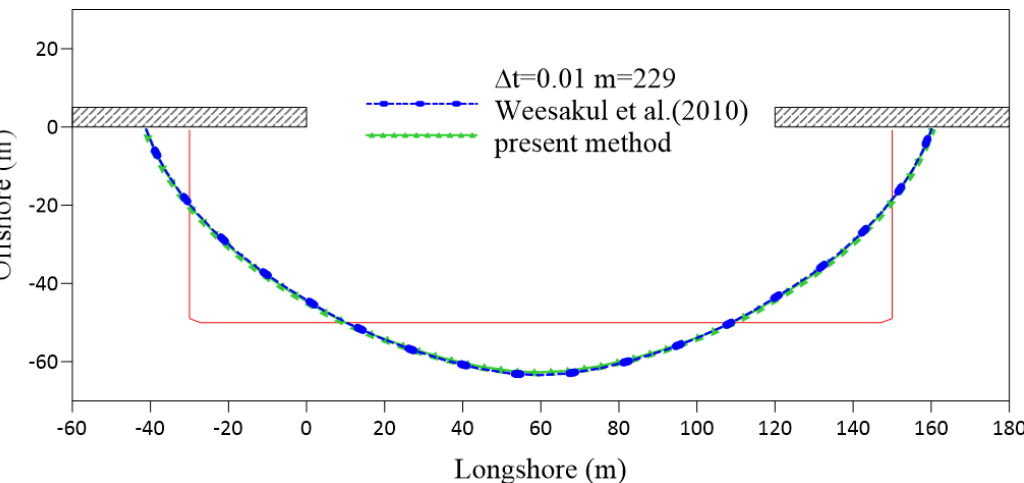
Figure 9. The profiles of steady shorelines by using the proposed model and the hybrid formulation [20].